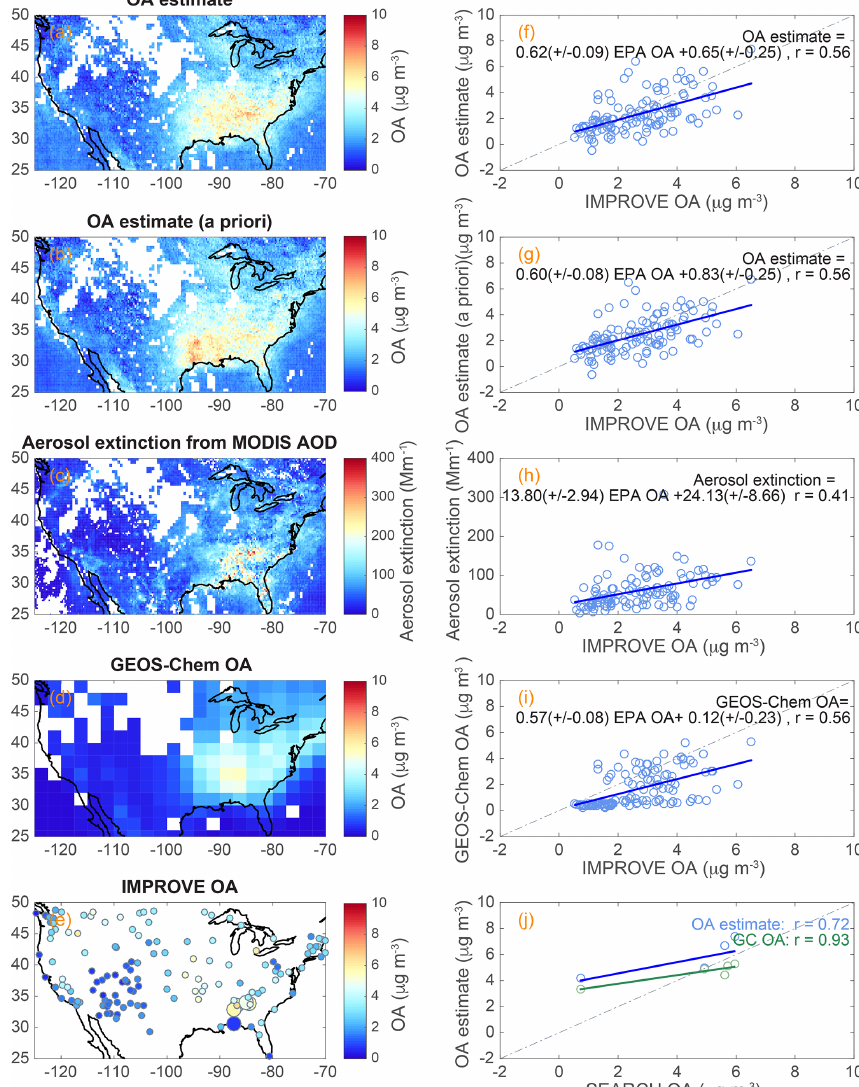
Figure 6. (a) The maps of (a) surface OA estimate (LUMP-SUM) with η from GEOS-Chem v9-02, (b) surface OA estimate (LUMP- SUM) with η from a priori profiles, (c) surface aerosol extinction derived from MODIS AOD, (d) GEOS-Chem simulated surface OA, and (e) IMPROVE (small dots) and SEARCH (large dots) network ground sites color coded with OA concentrations for August 2013. The scatter plots of the (f, g) surface OA estimate, (h) surface aerosol extinction derived from MODIS AOD, and (i) surface GEOS-Chem OA vs. IMPROVE network ground sites’ OA. IMPROVE sites’ OAs were corrected for evaporation. (j) The scatter plots of the surface OA estimate and GEOS-Chem OA vs. SEARCH network ground sites’ OA for August 2013. GEOS-Chem OA and the OA estimate did not have good correlations with SEARCH OA for other years (SI). For the scatter plots, linear regressions are shown (blue and green lines) and regression equations and correlation coefficients for the scatter plots are listed. The dashed lines in the scatter plots indicate the 1 : 1 line. Biomass burning data (UV aerosol index >1.6) were excluded in all